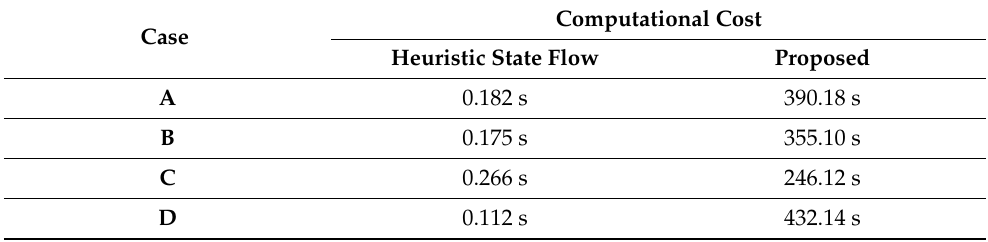
Table 4. Computational cost of solving proposed problem using MATLAB